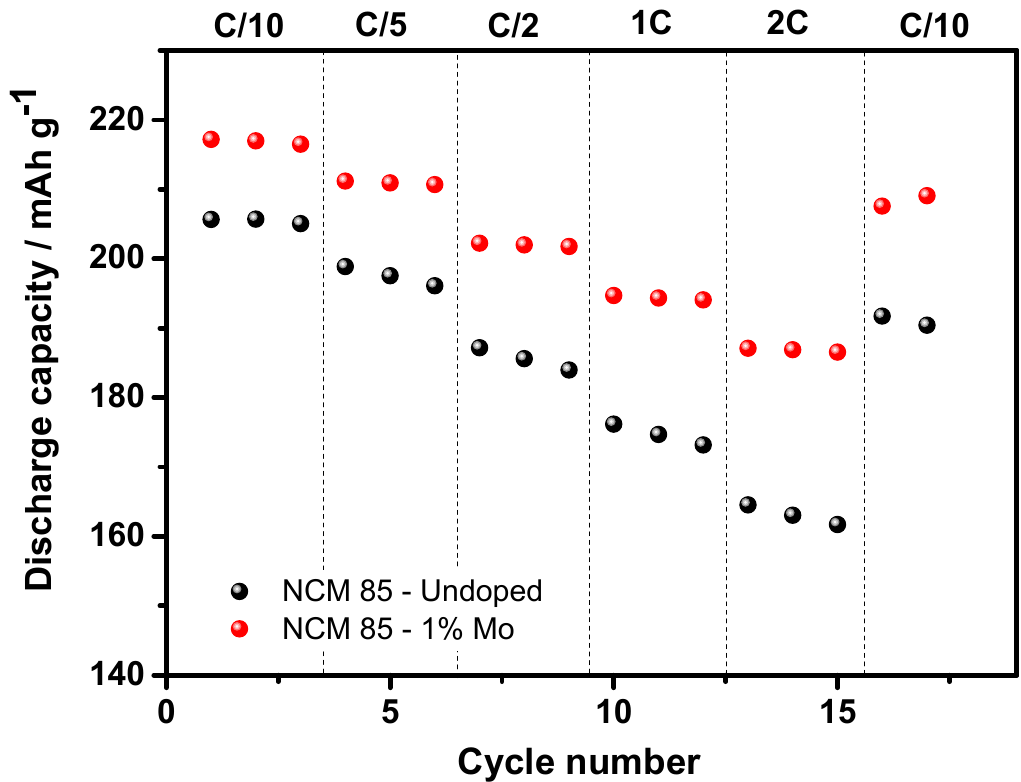
Figure 8. Discharge capacities measured at various C-rates (C/10, C/5, C/2, 1C, and 2C) from electrodes comprising undoped and 1 at. % Mo-doped NCM85 materials, at 30 °C.